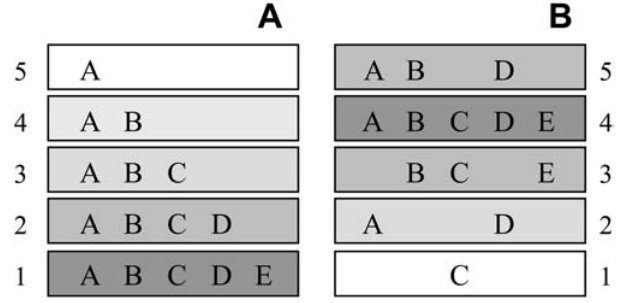
Figure 1. The Spatial Organization of Species Letters represent different PID species. Numbered rectangles represent different countries or